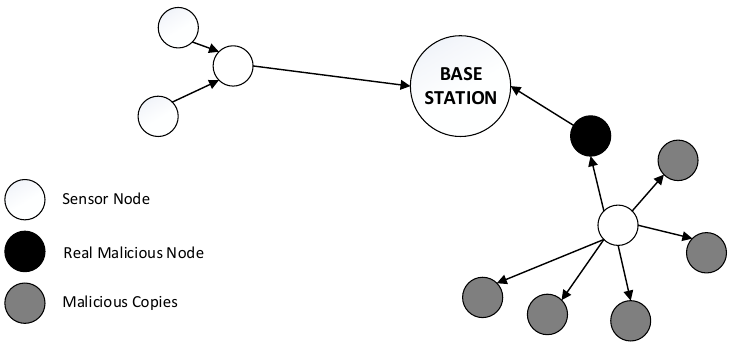
Figure 3. Demonstration of a Sybil Attack. Sinkhole Attack: The malicious node requests almost all the traffic from a given area through a node, creating a metaphorical pit between it and the base station. The illustration of a Sinkhole Attack is given in Figure 4.